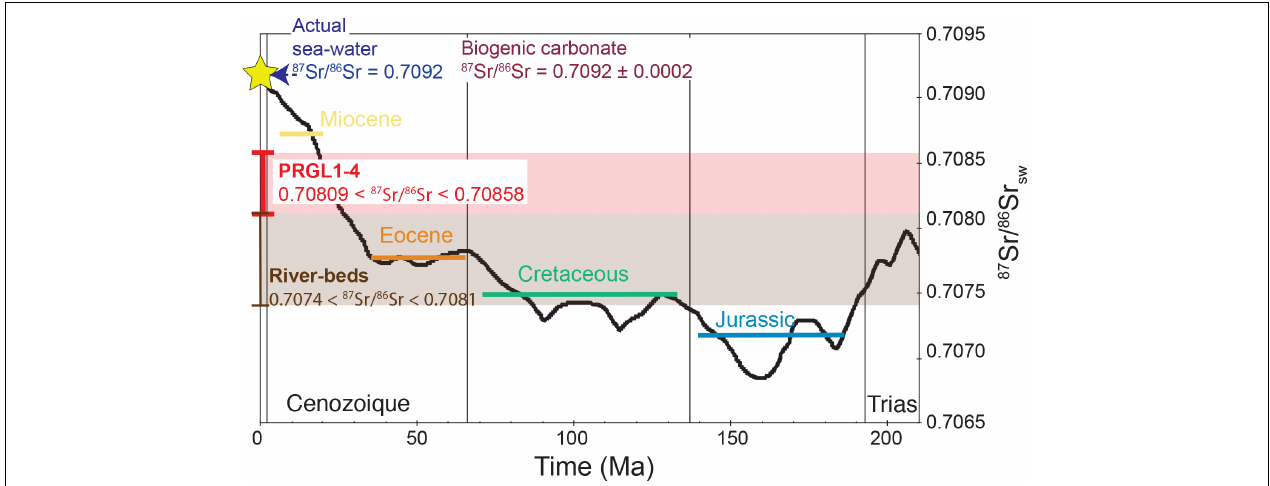
FIGURE 3 | 87 Sr/ 86 Sr evolution of sea-water over the last 210 Ma (black line; Howarth and McArthur, 1997; McArthur et al., 2001), pure biogenic calcite measured on foraminifera shells reflecting the actual sea-water composition. The range of PRGL1-4 leachate deposited over the last 500 kyr is illustrated by the red band and range of rivers sediment in the present-day GoL watershed by a brown band. The main carbonated stratigraphic units and their corresponding Sr isotope compositions in the GoL watershed are also highlighted with horizontal bars corresponding to their mean isotopic composition as defined in